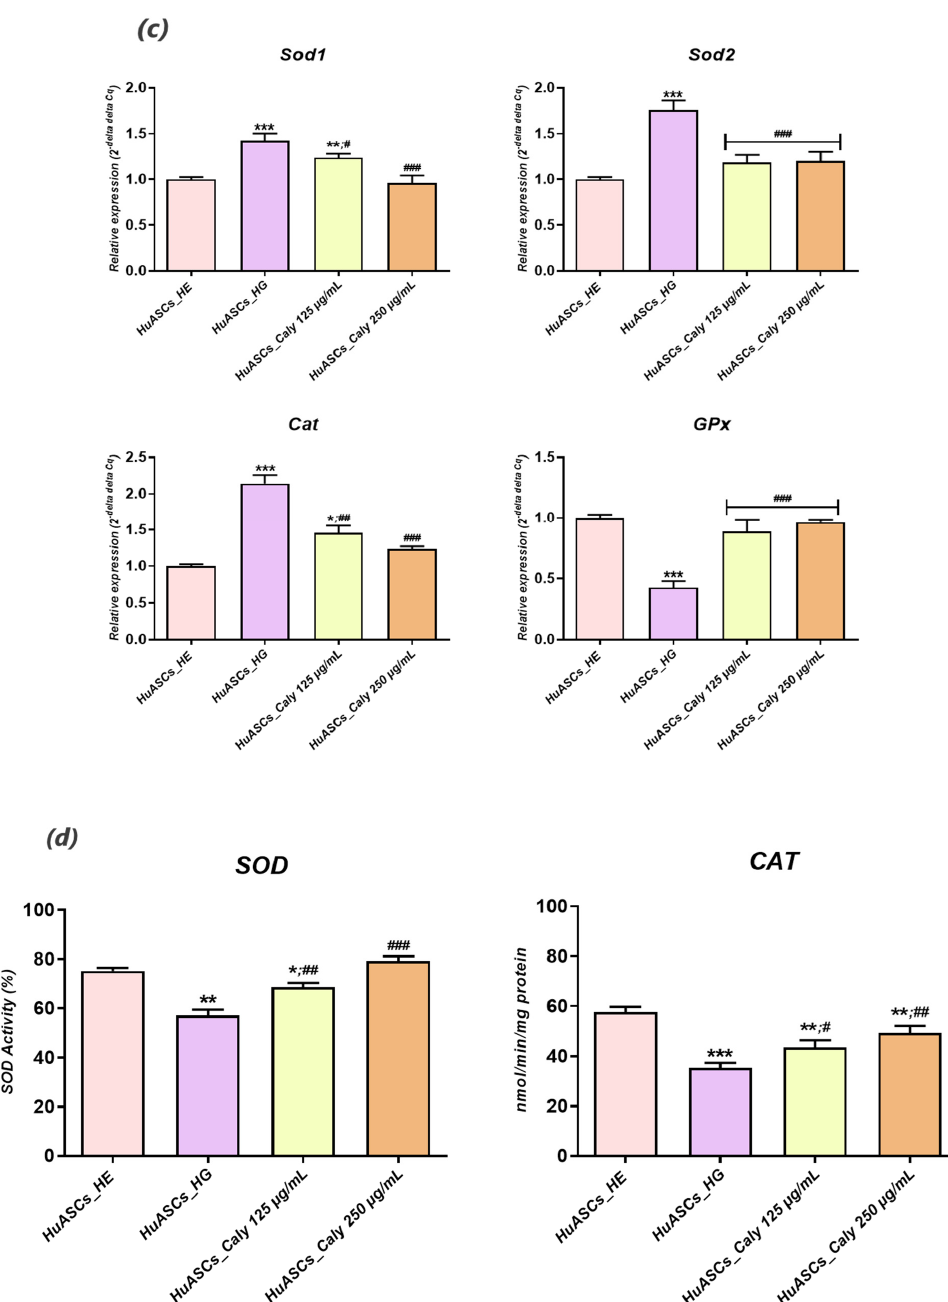
Figure 4. Antioxidant effect of total calystegine extract on HuASCs cells cultured under hyperglycaemic conditions. ( a ) Representative dot plots for ROS - /ROS + cells distribution. ( b ) Histograms depicting average ROS positive cells. ( c ) Relative gene expression average of endogenous antioxidant enzymes transcripts. ( d ) SOD and CAT enzymatic activities. Representative data from three independent experiments are shown ± SD (n = 3). An asterisk (*) indicates a comparison of the HG group to untreated healthy cells. A hashtag (#) indicates a comparison of the HG group pre-treated with calystegines to the HG untreated healthy cells. */# p < 0.05, **/## p < 0.01, ***/### p < 0.001. HuASCs_HE: human ASCs healthy untreated cells; HuASCs_HG: hyperglycaemic human ASCs cells exposed to a high concentration of glucose. HuASCs_Caly 125 µ g/mL: hyperglycaemic human ASCs cells pre-treated with 125 µ g/mL calystegines extracted and exposed to a high concentration of glucose. HuASCs_Caly 250 µ g/mL: hyperglycaemic human ASCs cells pre-treated with 250 µ g/mL calystegines extracted and exposed to a high concentration of